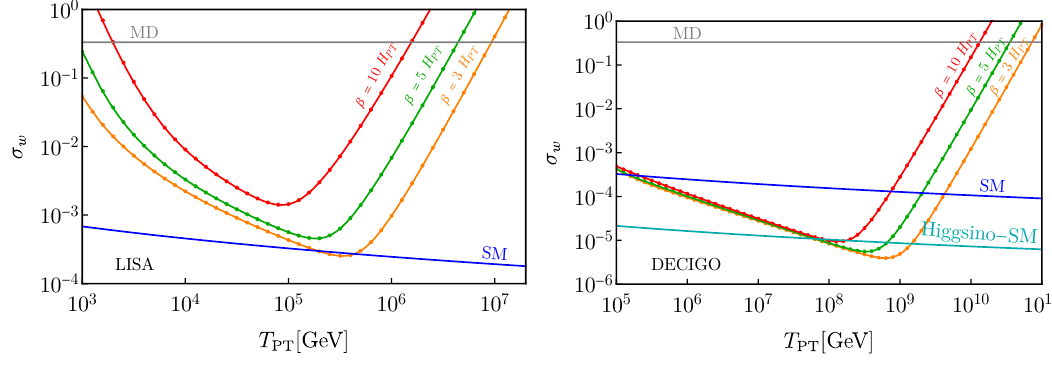
Figure 3 . The projected sensitivity, calculated using the Fisher matrix, of LISA (left) and DECIGO (right) to a constant equation of state near w = 1 / 3 as a function of the temperature at which the phase transition occurred for various β . β controls the duration of the phase transition generating the GW. For reference we show matter domination ( δw = − 1 / 3 ) as well as the SM and SM plus doublet dark matter predictions for δw versus